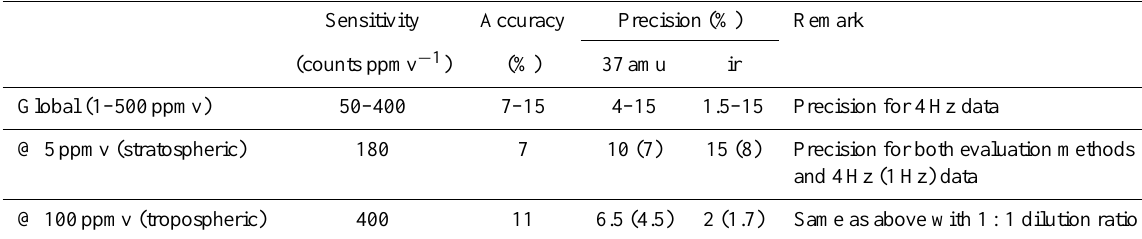
Table 1. Measurement range, accuracy and precision for AIMS-H 2 O. Remarks concern the parameters used to determine the precision and detection limit. For AIMS-H 2 O, the two values for precision correspond to the two evaluation schemes using ion mass 37amu (H 3 O + (H 2 O)) and ion ratio,